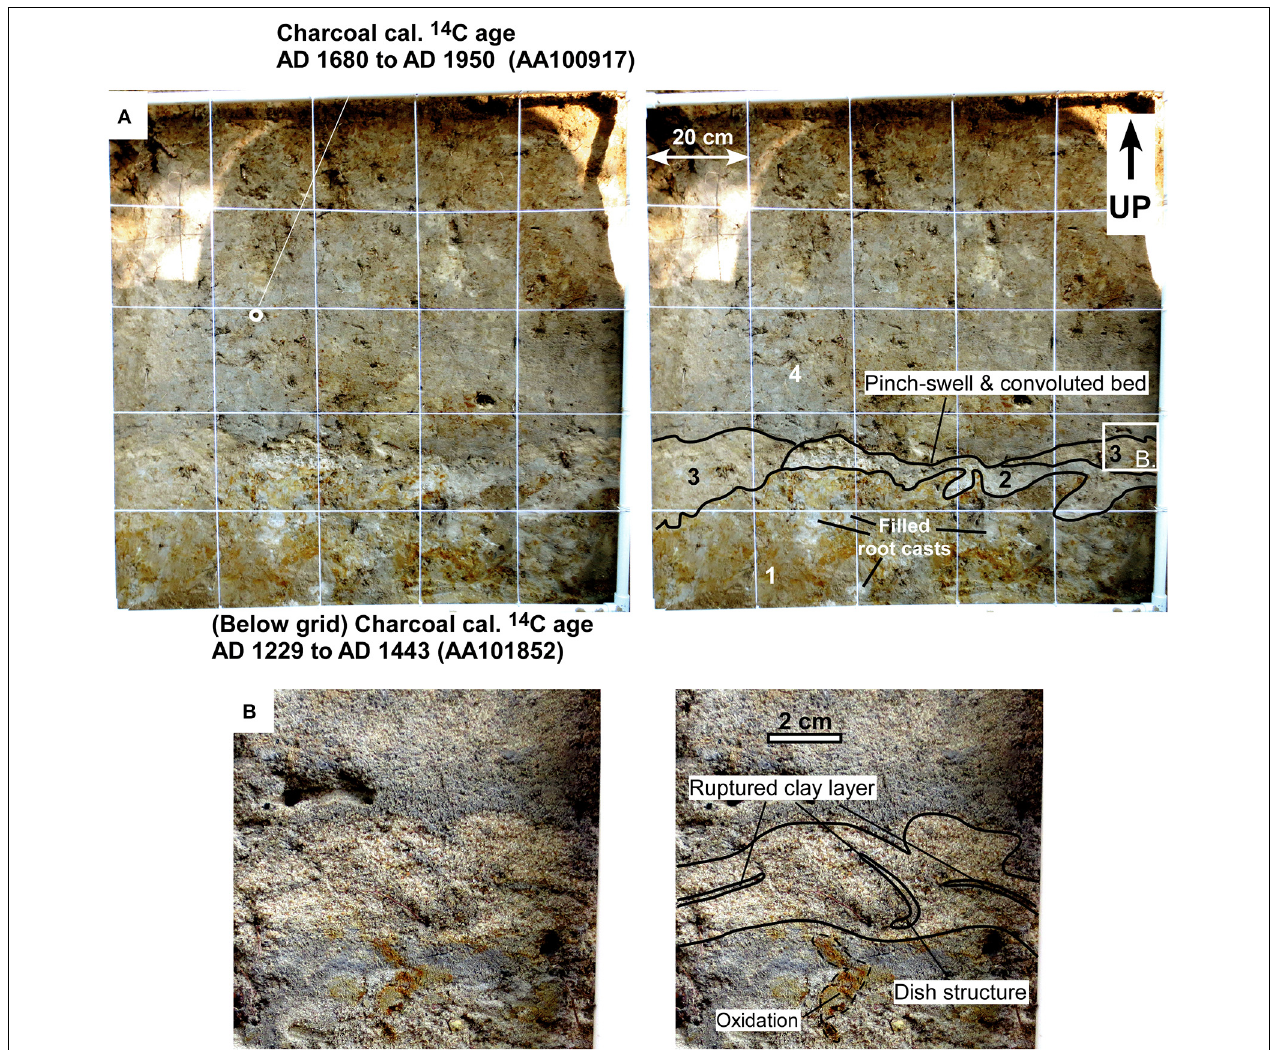
FIGURE 5 | Site I (Sandy Creek, 33.57962 ◦ N, 91.72241 ◦ W)—Top is up. Location of (B) is shown on (A) . (A) Uninterpreted photograph (left) and interpreted photograph (right) of 1 × 1 m grid on vertical excavation showing convoluted bedding and pinch-swell features in Units 2 and 3 interpreted to be caused by ground shaking and liquefaction. Unit 1, Sandy Creek overbank, massive sandy clay; Unit 2, Convoluted Sandy Creek channel, medium-bedded gravel; Unit 3, Convoluted Sandy Creek point-bar, medium/thin interbedded clay and sand; Unit 4, Sandy Creek overbank,